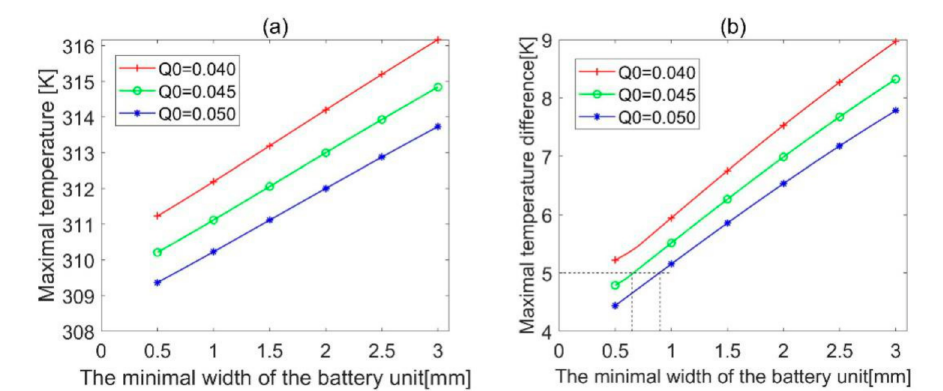
Figure 8. The effect of the minimal width of battery unit on the temperature distribution for various inlet airflow rates: ( a ) effect on maximal temperature, ( b ) effect on maximal temperature difference. ( θ dp = 15 ◦ , θ cp = 15 ◦ , w dp = 5 mm, w cp = 5 mm).